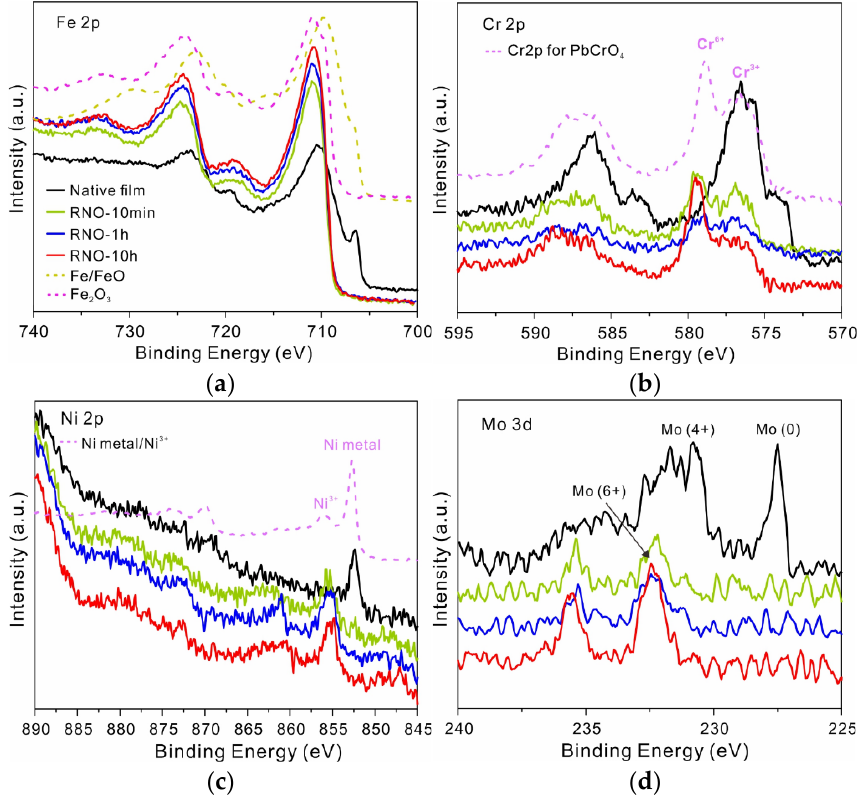
Figure 2. Chemical composition of the RNO film: ( a ) X-ray photoelectron spectra of the Fe 2p core levels of 316L SS films after DBD processing for various times and standard spectra of Fe 0 , Fe 2+ , and Fe 3+ states for reference. ( b ) Cr 2p core levels of the films and standard spectra of Cr 3+ and Cr 6+ for reference. ( c ) Ni 2p core levels of the films and standard spectra of metal Ni and Ni 3+ ions for reference. ( d ) Mo 3d core levels of the films.